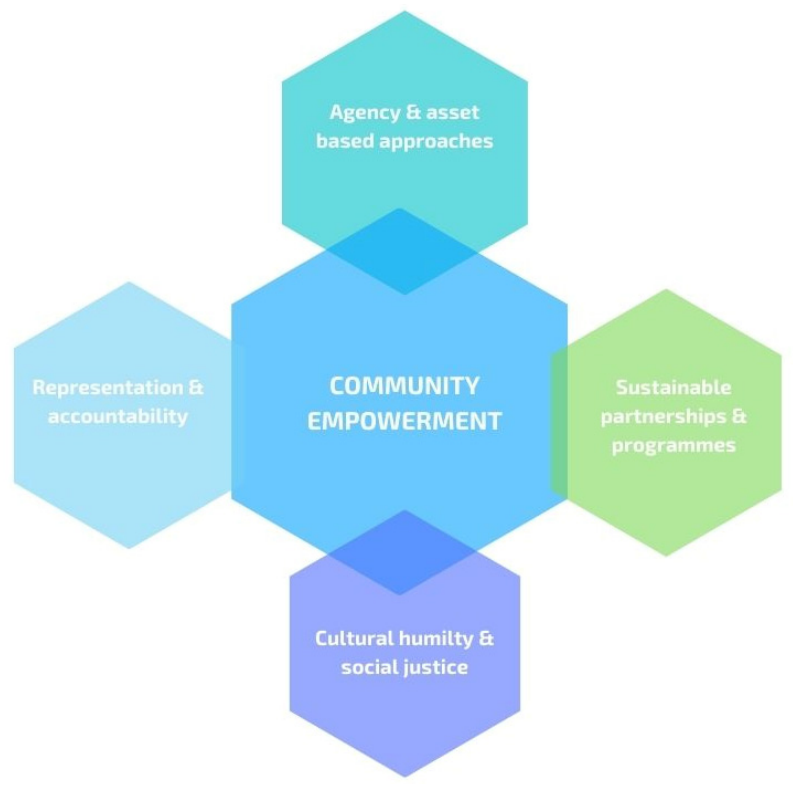
Figure 2. Moving beyond community engagement to community empowerment, adapted from (Osuafor et al. 2021).